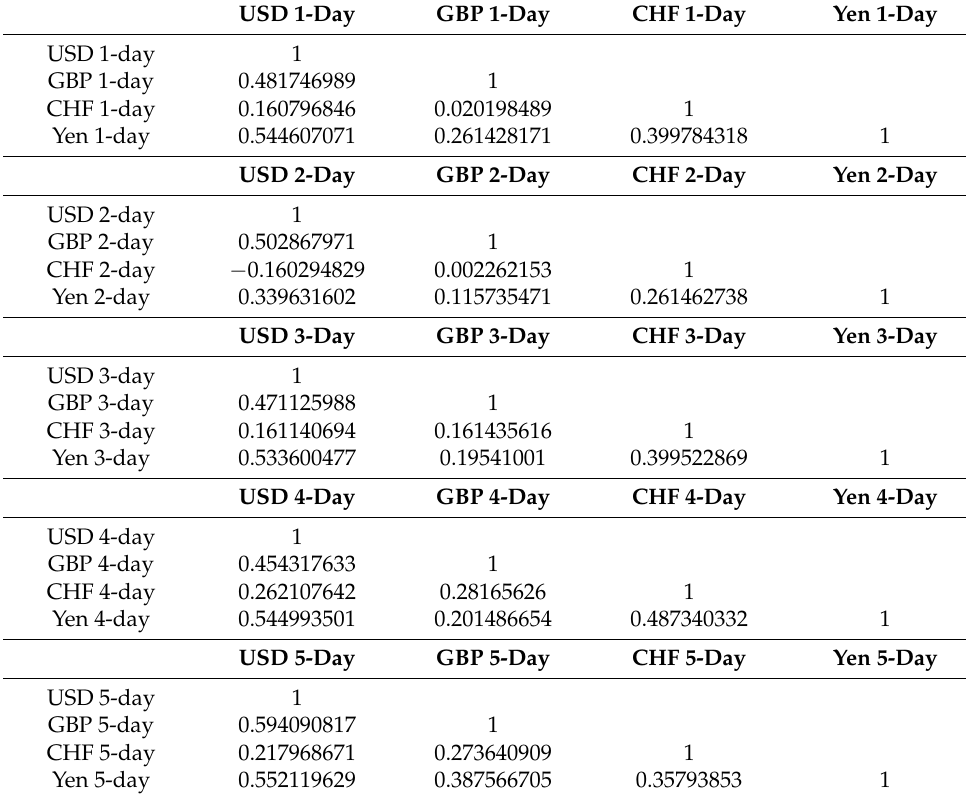
Table 2. Correlation Matrix of